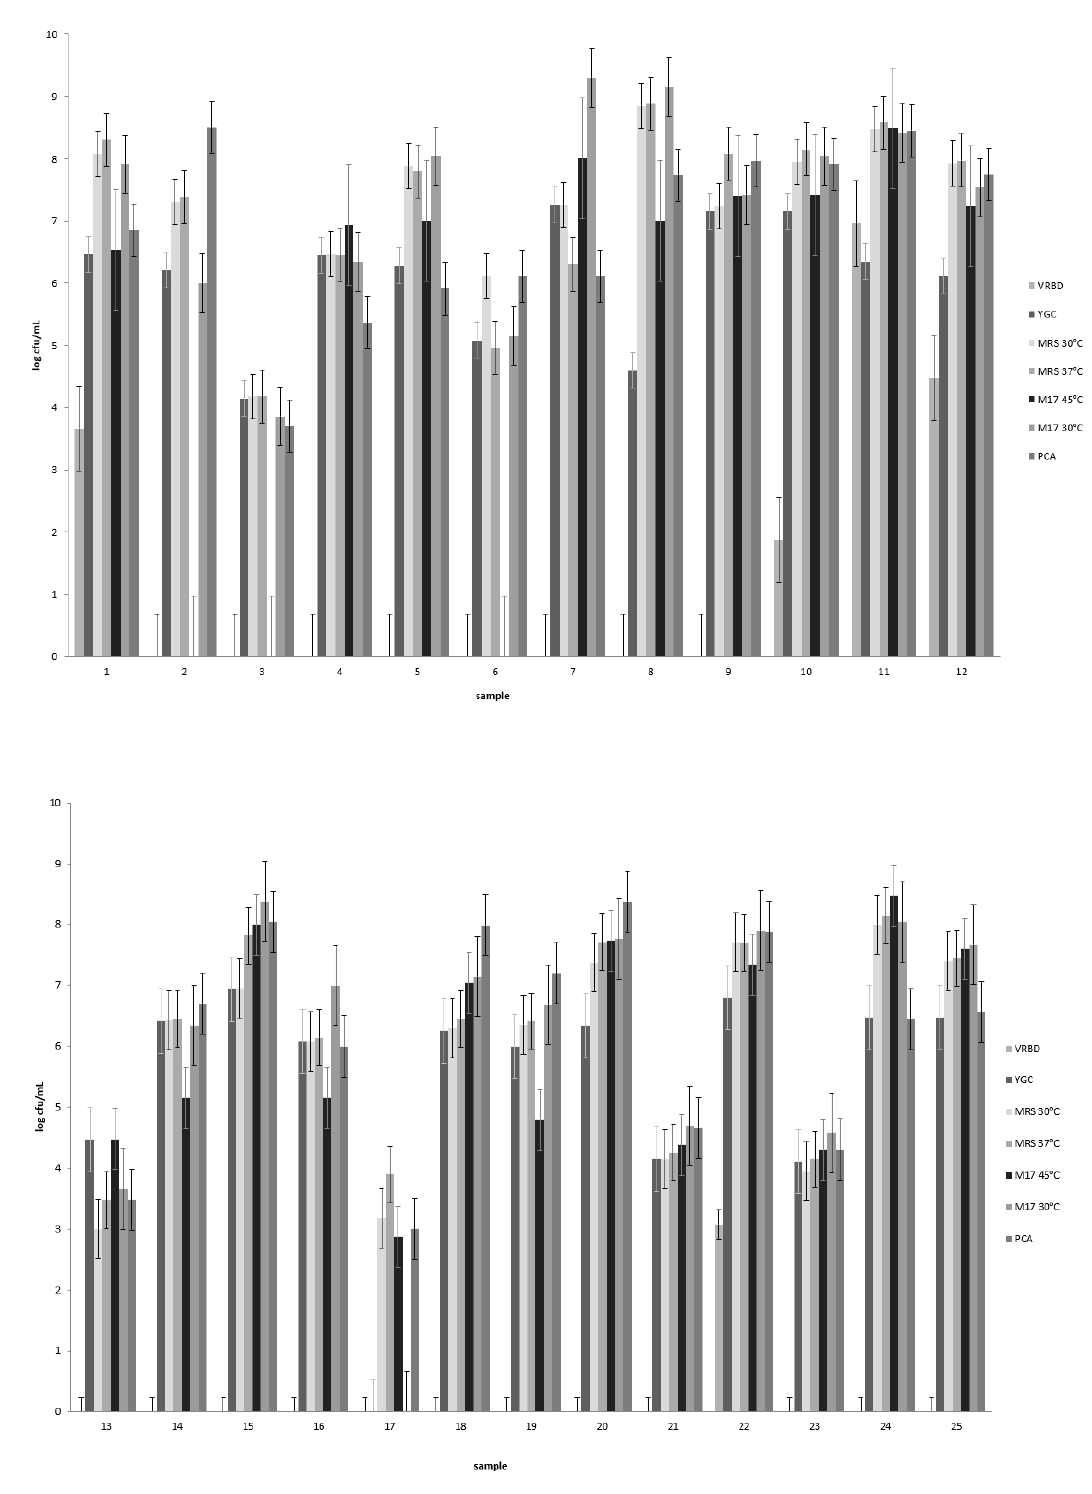
Figure 1. Bacterial counts in 25 nono samples obtained from local Fulani processors and markets in Kano, Katsina, Jigawa, and Bauchi states in northern Nigeria. Enterobacteria counts were determined on violet red bile agar (VRBD), yeasts on yeast extract–glucose–chloramphenicol agar (YGC); lactic acid bacteria on de Man, Rogosa, and Sharpe medium (MRS); and lactococci and streptococci on M17 medium. The total aerobic, mesophilic counts were determined on plate count agar (PCA), and the standard error is shown. See text for details of incubation conditions.